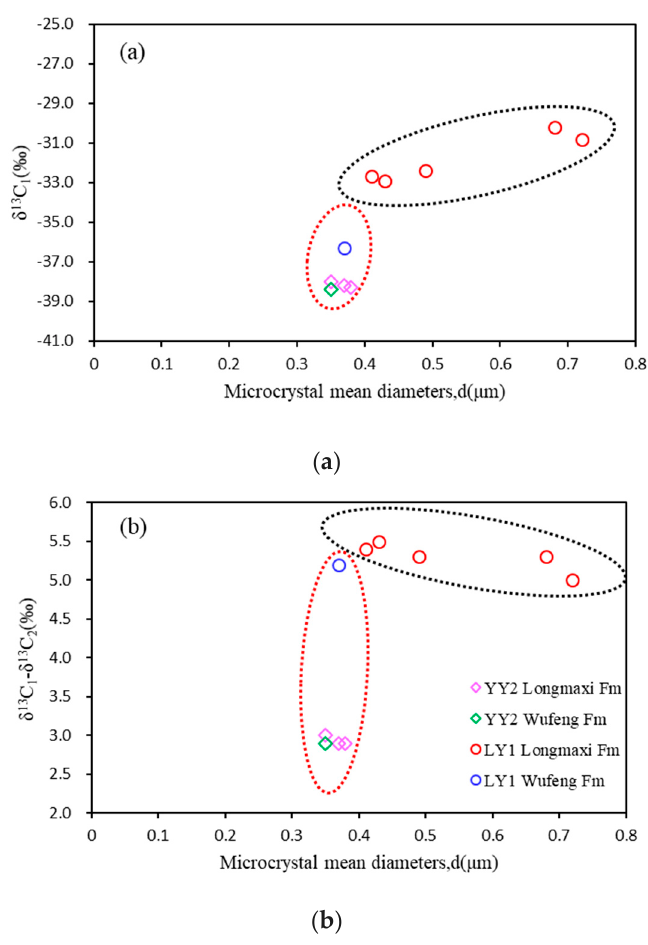
Figure 11. ( a ) Relationship between microcrystalline mean diameters and the value of the δ 13 C 1 ; ( b ) relationship between microcrystalline mean diameters and the value of the δ 13 C 1 - δ 13 C 2 .